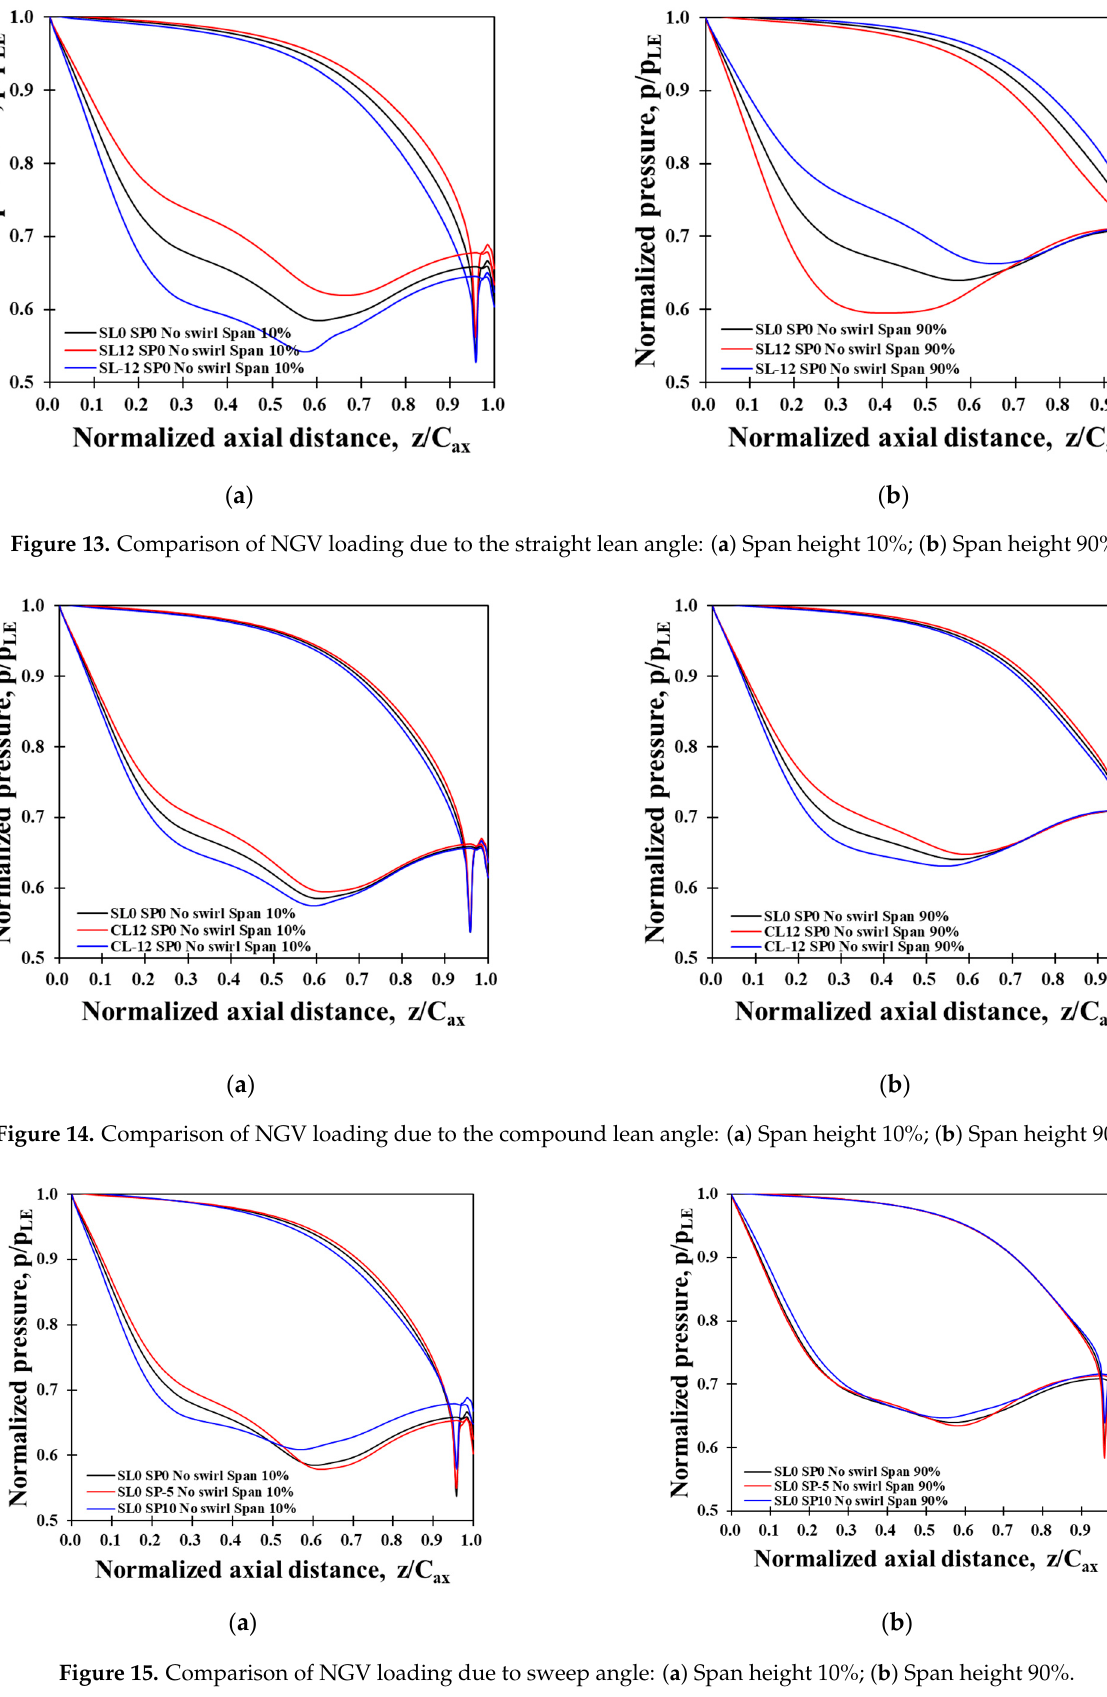
( a ) ( b ) Figure 16. Comparison of NGV loading of the models with maximum efficiency (SL0 SP0 No swirl) and minimum effi- ciency (SL-12 SP-5 No swirl) model: ( a ) Span height 10%; ( b ) Span height 90%.